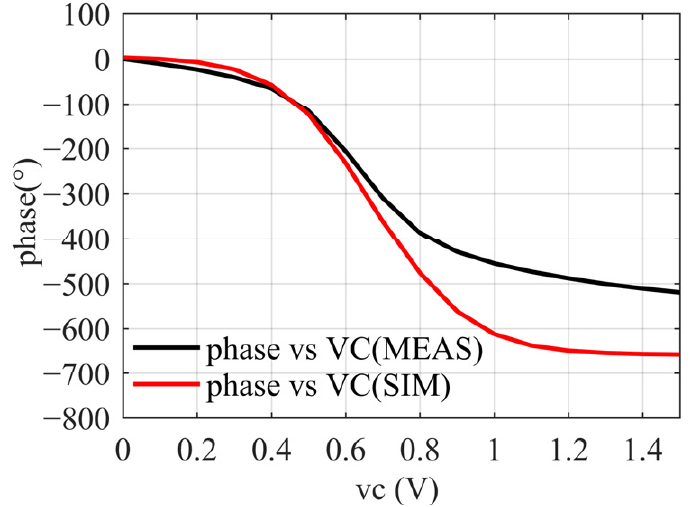
Figure 24. Results of phase shift vs. control voltage.